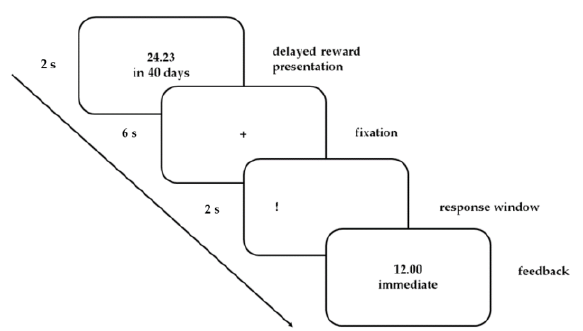
Figure 1. Main delay discounting functional magnetic resonance imaging (fMRI) task. Each of the 90 trials began with the presentation of the larger later (LL) reward (2 s), followed by a fixation cross ( + ; 6 s) and a response window (2 s). During the response phase, an exclamation mark (!) presented on the left or right side of the screen indicated whether the left or right button had to be pressed for the LL reward on that trial. Decisions for the LL reward were mapped to the right button in half of all trials and to the left button in the other half. Before the fMRI session began, participants were informed that they could choose the alternative smaller sooner (SS) reward (an individually determined fixed value between 5 € and 15 € , based on the individual discounting parameter k estimated in the pre-scan calibration session; see Supplementary Methods) by pressing the button on the opposite side. Feedback confirmed responses immediately. Between trials, a blank screen was presented for a jittered interval of seven seconds on average.